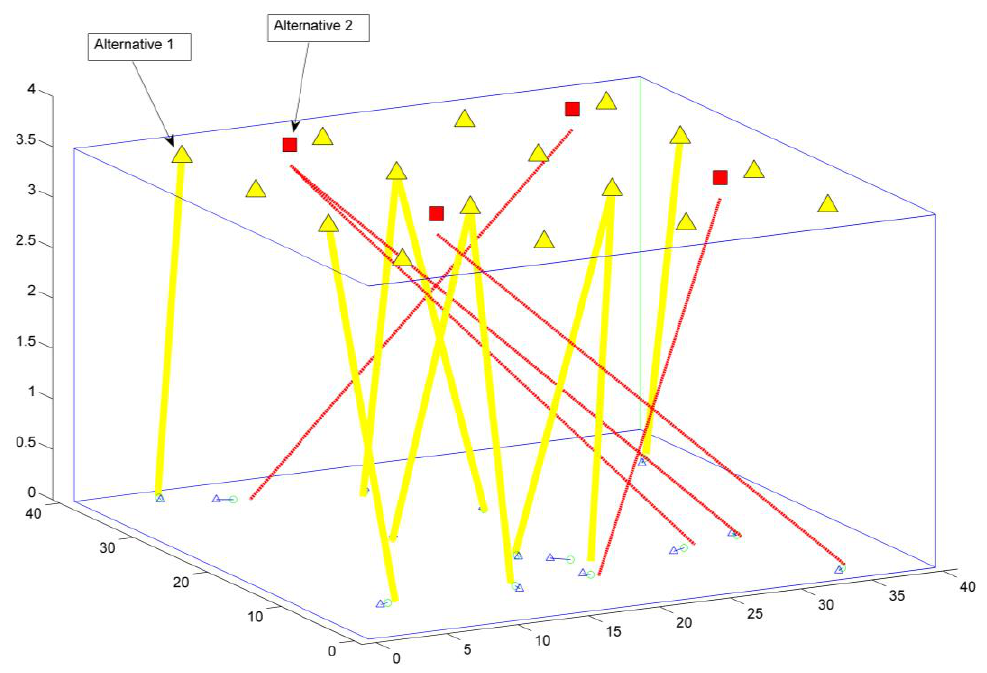
Figure 7. Example of DM alternatives in hybrid LiFi network.